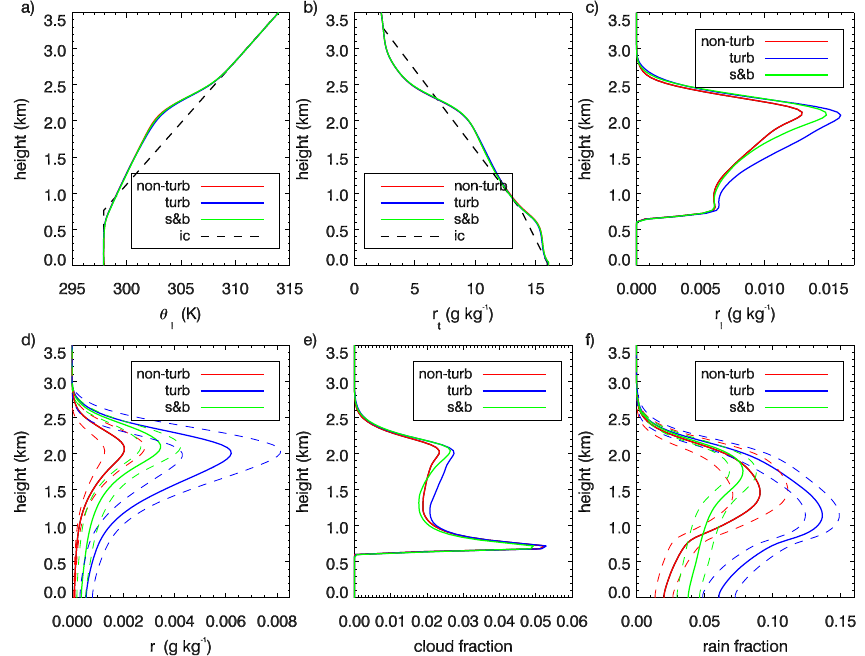
Figure 3. RICO cloud properties for the simulations that use the turbulent (blue) and non-turbulent (red) microphysics parameterisations of Franklin (2008) and the microphysics scheme of Seifert and Beheng (2001; green). The initial conditions are given by the black dashed lines. (a) Liquid water potential temperature (K), (b) total water mixing ratio (gkg − 1 ) , (c) liquid water mixing ratio (gkg − 1 ) , (d) rain water mixing ratio (gkg − 1 ) , (e) cloud fraction and (f) rain fraction. The coloured dashed lines in (d) and (f) represent the ± standard deviation from the temporal means, with these fields being the only ones that show significantly different